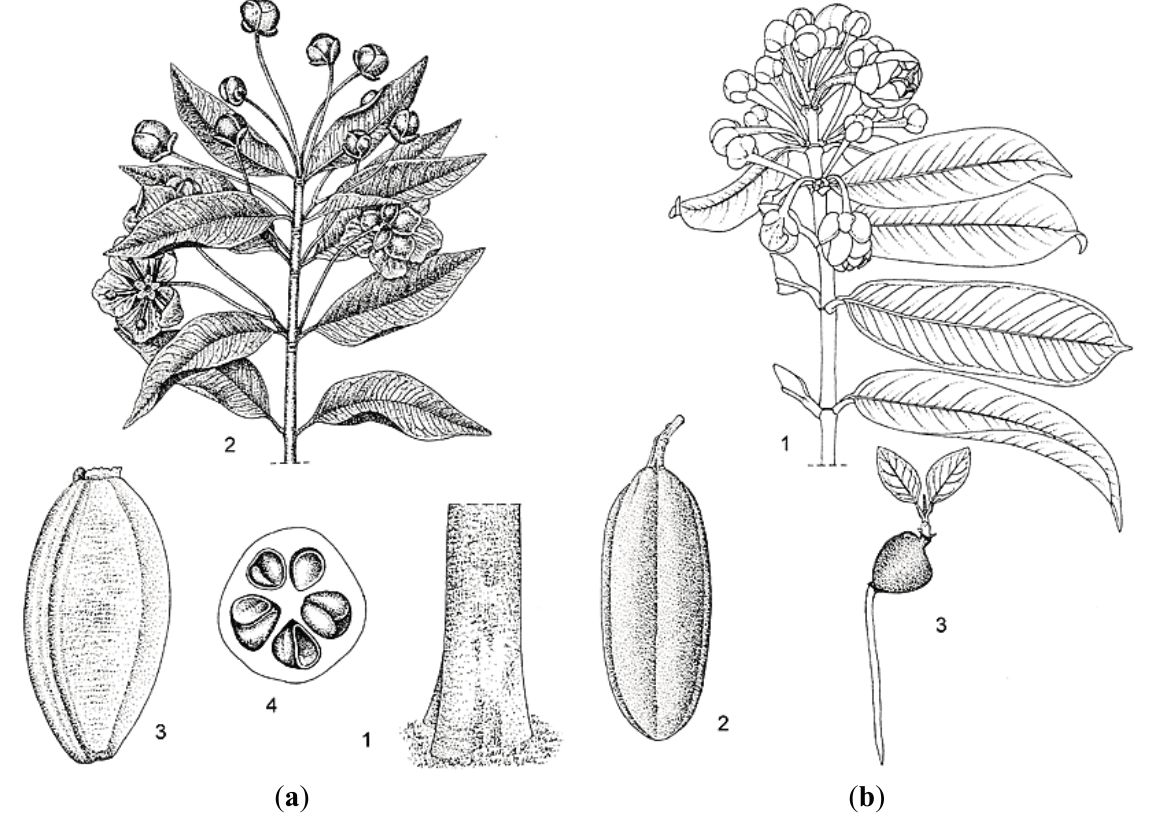
Figure 2. Line drawings detailing characteristic botanical features of ( a ) Allanblackia floribunda ( 1 , base of bole; 2 , flowering twig; 3 , fruit; and 4 , fruit in cross section showing seeds); and ( b ) A. parviflora ( 1 , flowering twig; 2 , fruit; and 3 , seedling). Line